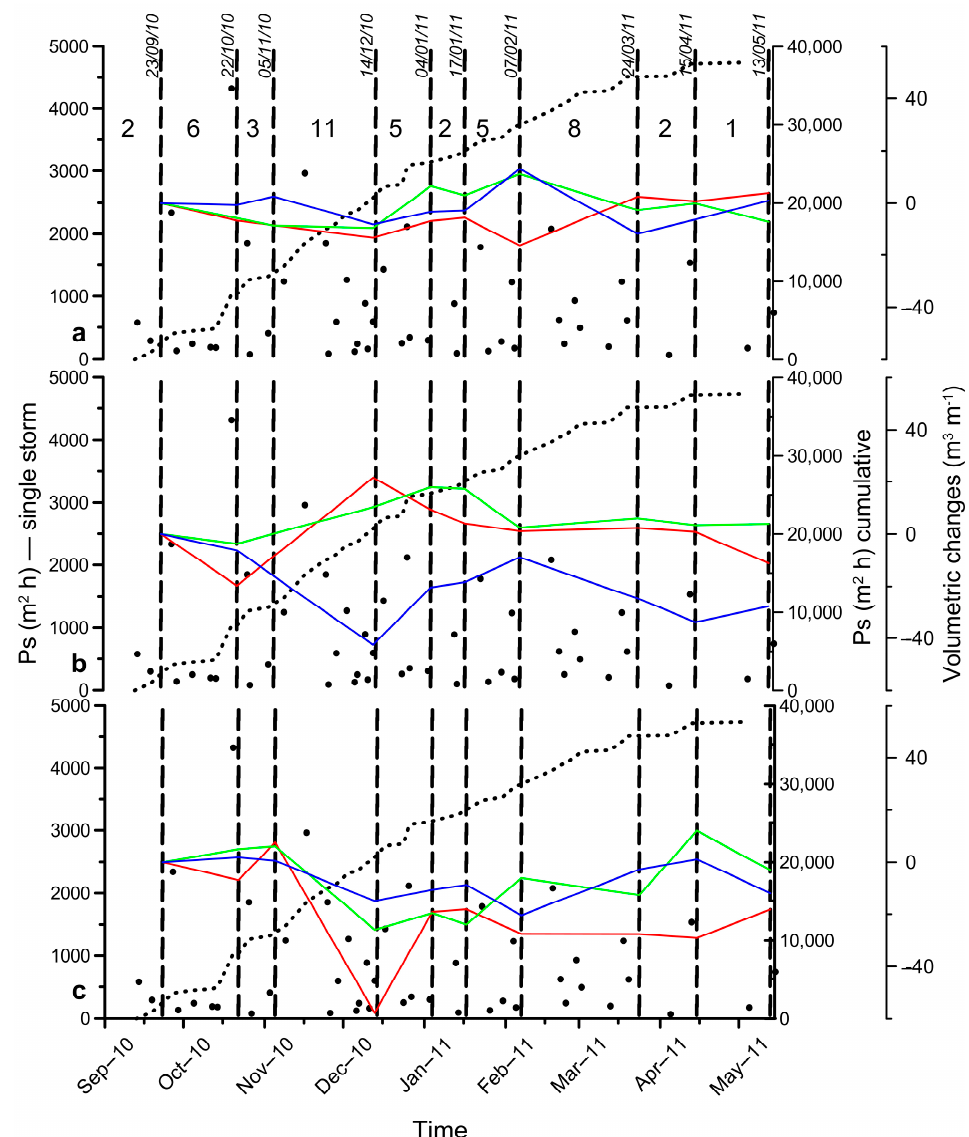
Figure 7. The cumulative volumetric changes (m 3 m − 1 ) on the following beach profiles: Mari Ermi ( a ); Is Arutas ( b ); and Maimoi ( c ). The red lines indicate the cumulative volumetric variation (m 3 m − 1 ) on northern profiles, the green lines on central profiles, and the blue lines on southern profiles. The dots represent the singles ‘storm power index’ (values on y axis on the left); the dotted lines represent the cumulative ‘storm power index’ (values on y axis on the right). The dashed vertical lines represent the date of the topographic survey.